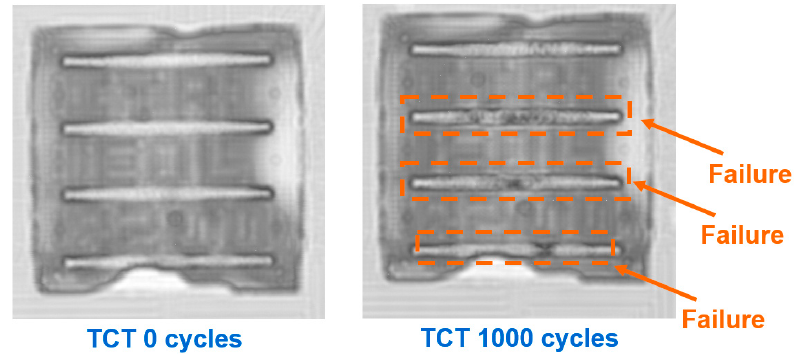
Figure 4. Comparison of satellite acoustic technology (SAT) images obtained at the beginning of the experiment (zero cycle) and those captured after 1000 temperature cycling test (TCT cycles).